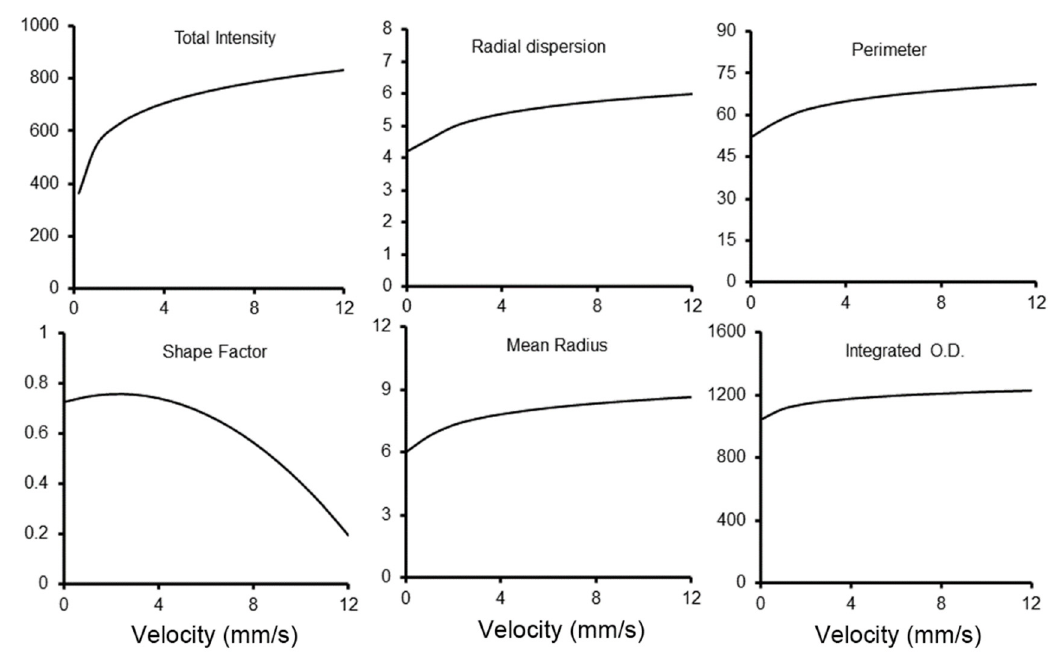
Figure 6. Morphometric analysis of methylene blue loading with variable load velocity. The morphometry measures reflecting the area or radial dispersion of the tracer increased toward an apparent velocity plateau of 5 mm/s. Shape factor demonstrated progressive irregularities with increasing velocity. The curves reflect the aggregate best fit curve based on replicate measures of contact time and compressive force.